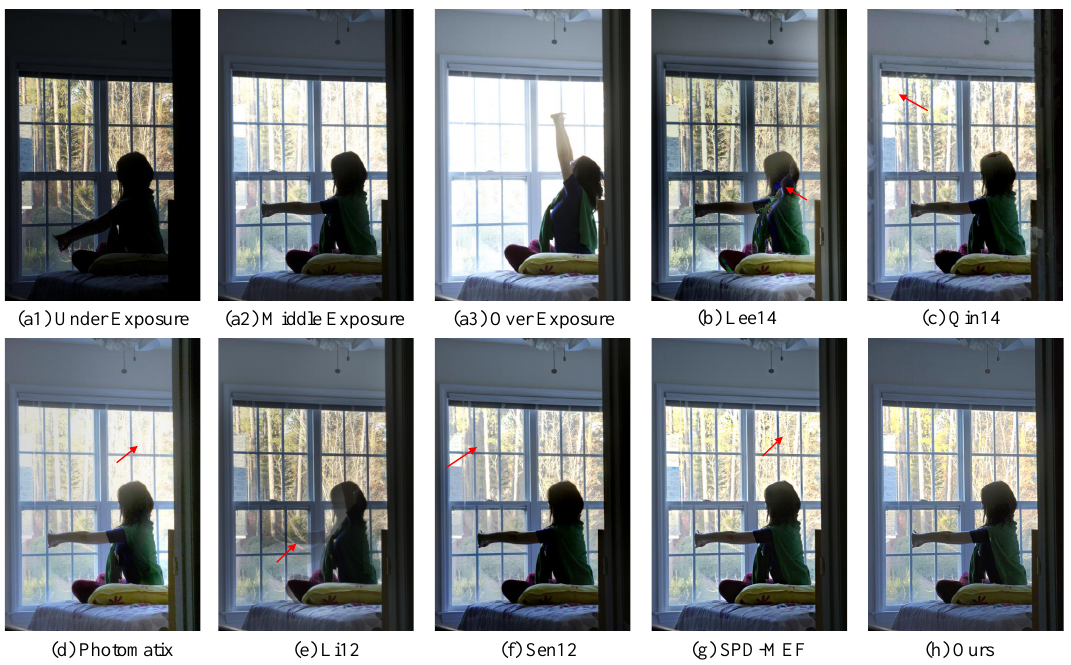
Figure 5. An example of a multi-exposure source image sequence ( a1 – a3 ) and fused images ( b – h ) gener- ated by [5,11,14,33–35] and our method,